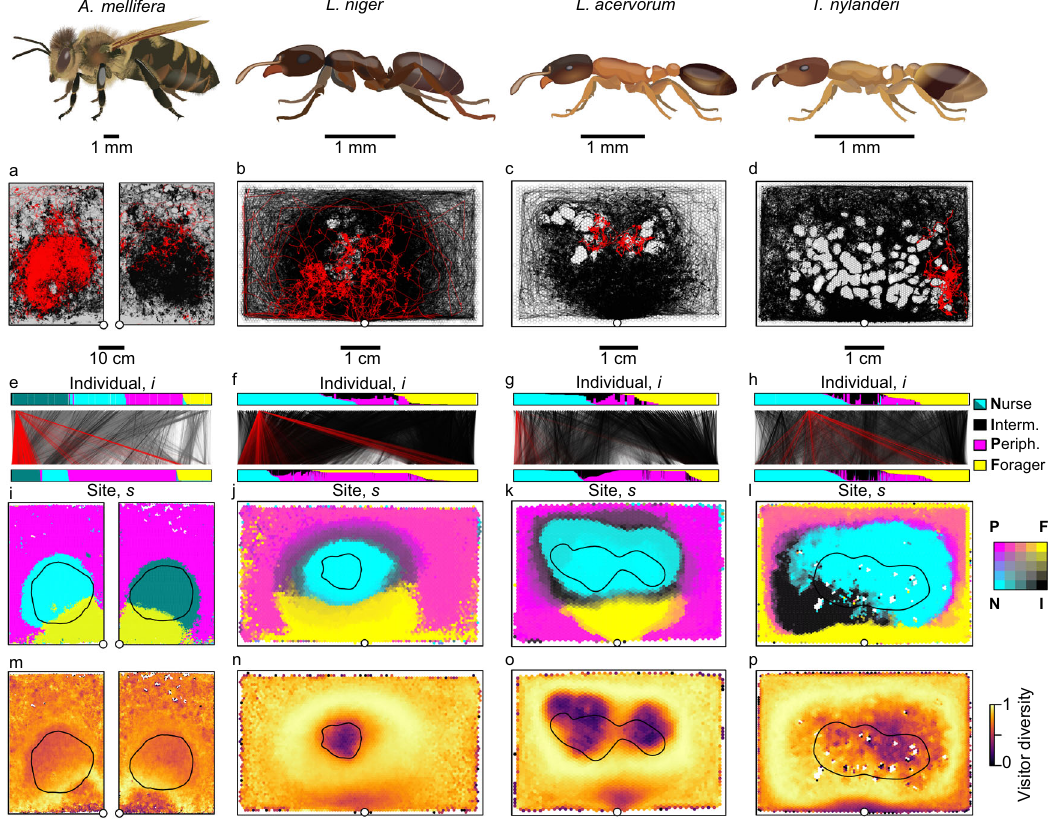
Fig. 1 | Spatial organisation in four species of social insects. a – d One-hour trajectories of all workers in an example colony. The nest interior is divided into discretesitesde fi nedbyahexagonalgrid.Thetrajectoryofasinglefocalindividual is shown in red. e – h Corresponding site-visit networks. Edges connect individuals (upperlayer)tothesitestheyvisit(bottom layer).Edgewidthsareproportionalto the number of visits. The module scores for each node are indicated by the coloured bars (Nurse (N): cyan; Intermediate (I): black; Peripheral (P): magenta; Forager(F):yellow).Inthehoneybeecolony,twodifferentshadesofcyanareused to depict the two distinct nurse modules. The connections of the focal individual are shown in red. i – l Map of the nest fl oor. Sites are coloured according to the linear combination of CMYK colours for each module, weighted by its module scores; thus a site with a forager score of 1 ( ‘ pure ’ forager site) is shown in yellow (top right corner in the colour key), while a site with a forager score of 0.5 and a